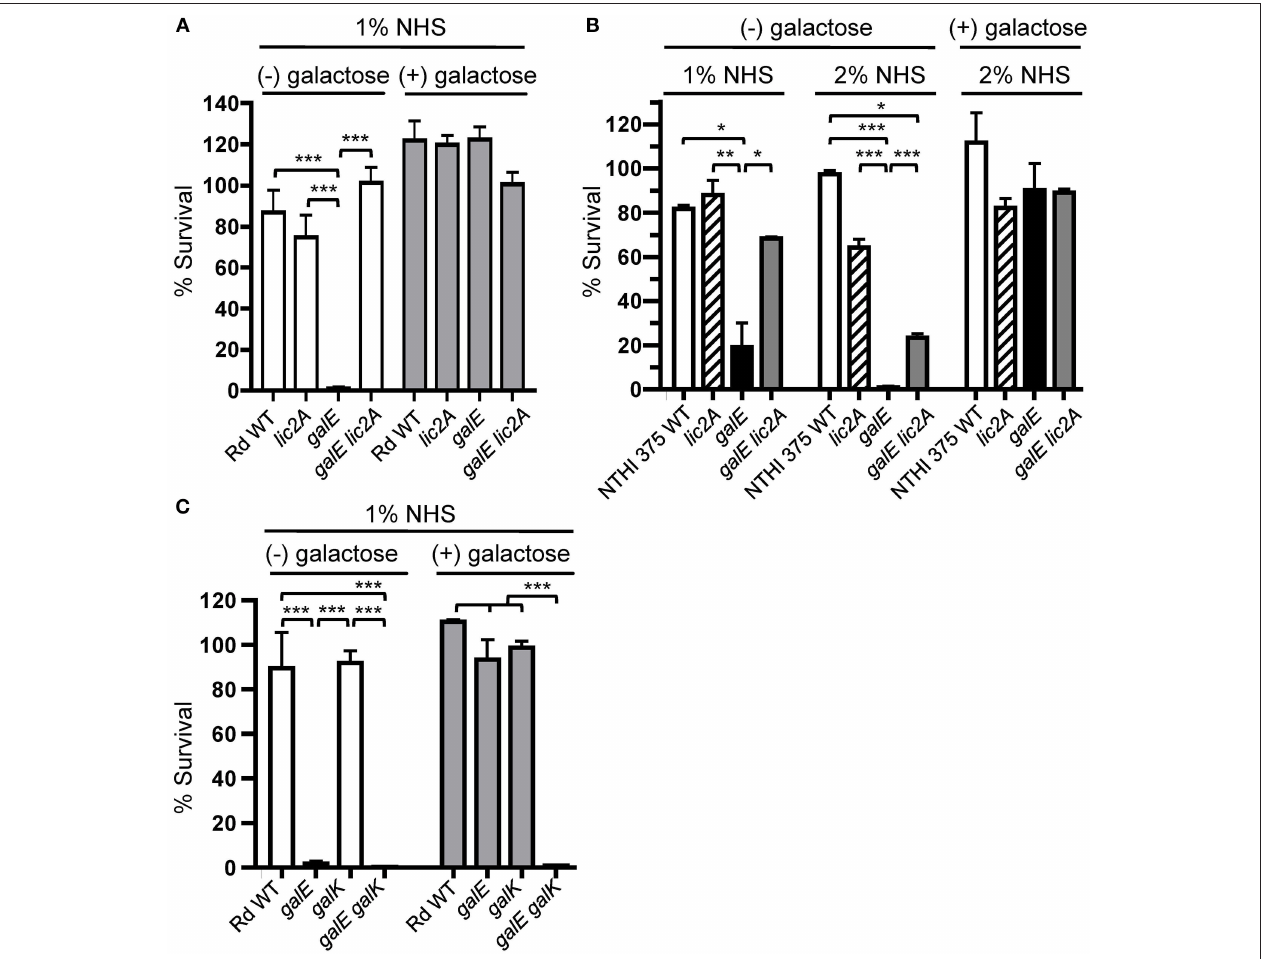
FIGURE 6 | Deletion of lic2A or growth on galactose alleviates sensitivity of the galE mutant to bactericidal effects of NHS and blocking galactose catabolism in the galE mutant confers serum sensitivity. Viability of H. influenzae wild-type (WT) Rd (A,C) and NTHi strain 375 (B) and isogenic single and double deletion mutants in their respective strain backgrounds grown on MIc medium containing sialic acid (MIc SA ) in the absence (-) or presence ( + ) of 1 or 0.5% galactose for Rd and NTHi 375, respectively, following incubation with the percent of NHS indicated at 37 ◦ C for 30min. Percent survival is the ratio of CFU recovered at 30min from serum treated samples to CFU recovered from NHS 1 i treated samples. Log-transformed survival ratios were evaluated by one-way ANOVA with Bonferroni’s multiple comparison test (* p < 0.05, ** p < 0.01,*** p < 0.001). The mean of duplicate assays is shown. Lower limit of detection is approximately 0.25%